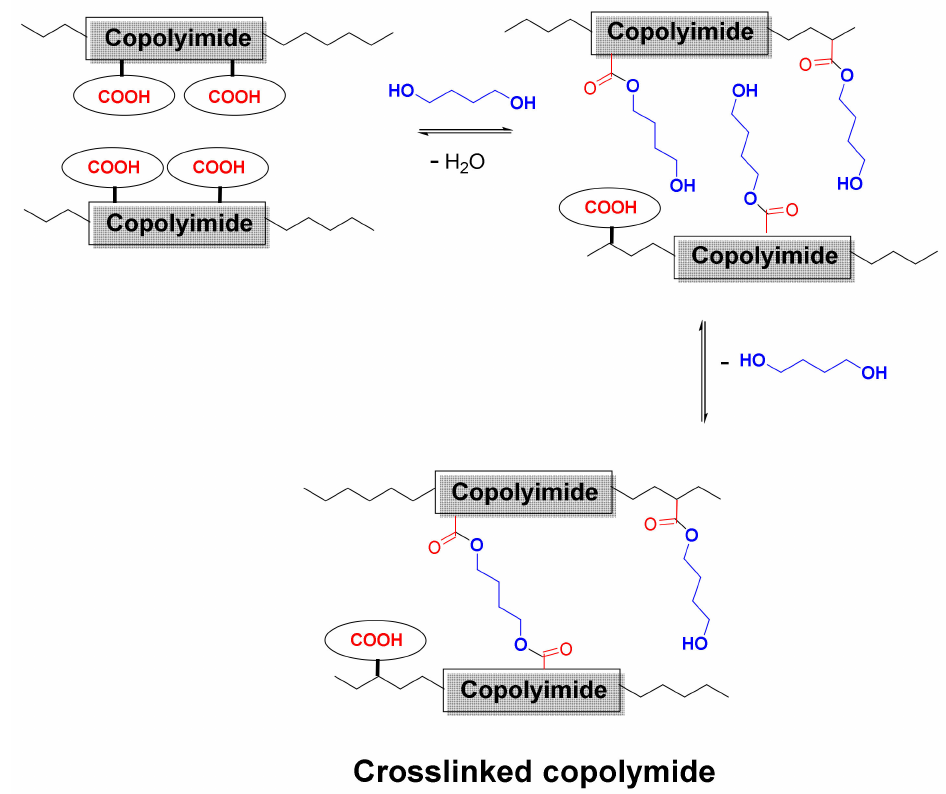
Figure 4. Scheme of covalent crosslinking reaction in a copolyimide incorporating